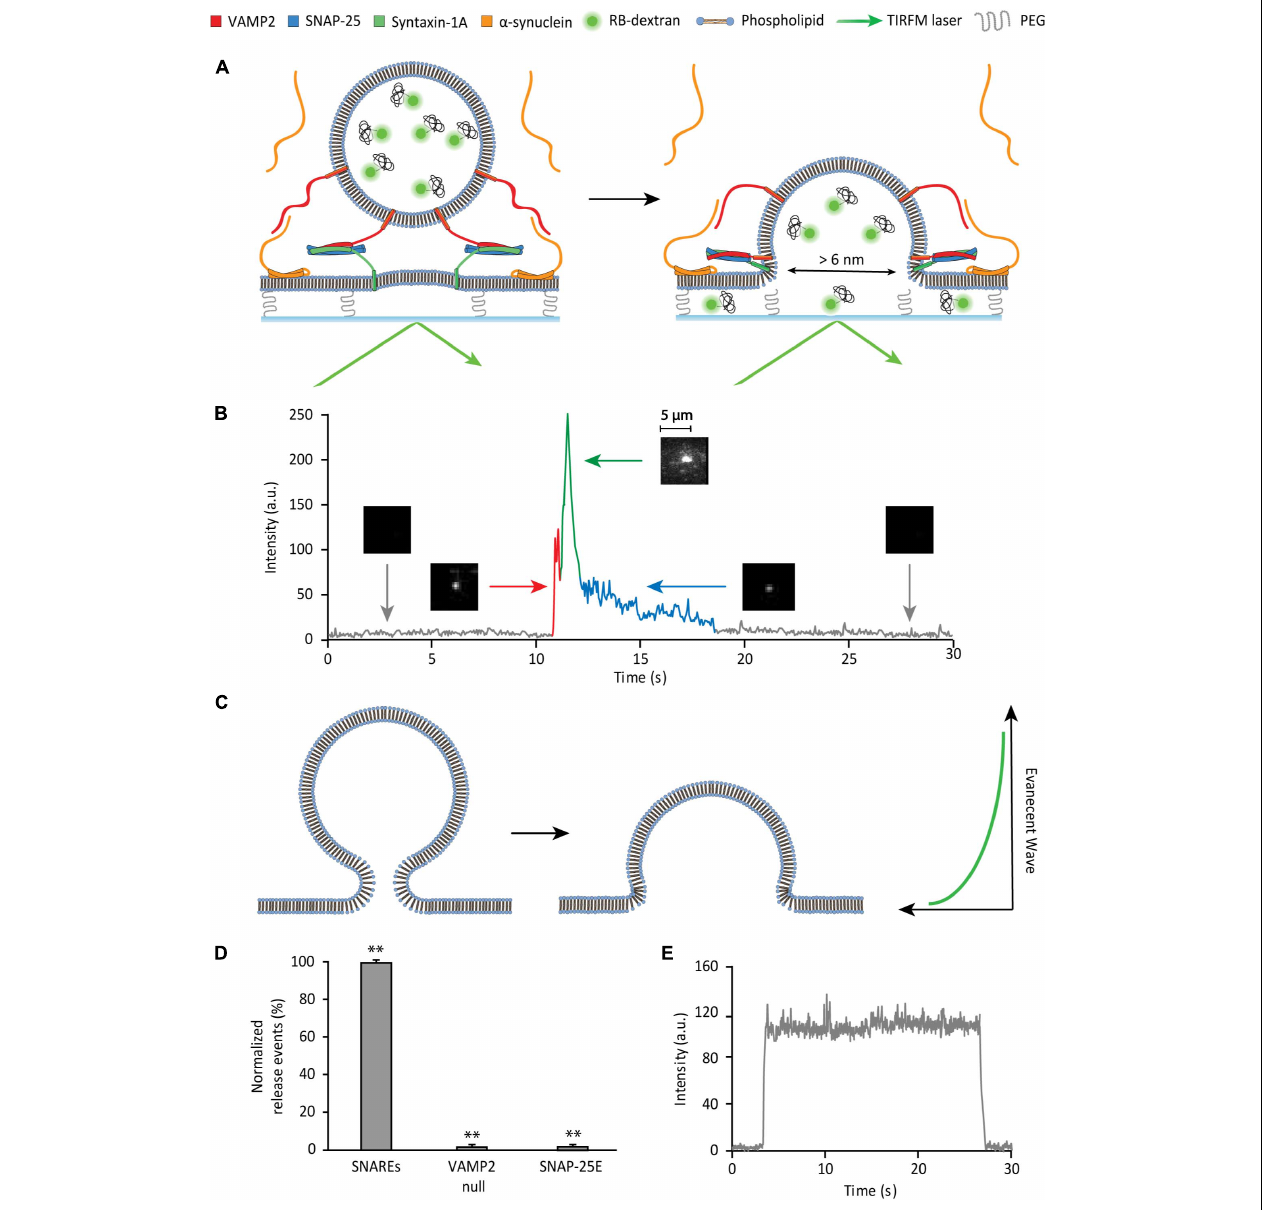
FIGURE 2 | Single vesicle-to-supported bilayer fusion assay to monitor a large fusion pore. (A) Schematic of the content release assay. (B) Detection of large pore fusion event. Before the injection of vesicles, there is a black background (gray trace). As vesicles are injected and dock to the surface, there is a spike in the fluorescence intensity (red trace) visualized by a fluorescent spot. After a short plateau (red trace), the vesicle develops a large fusion pore, where the fluorescence intensity increases sharply and declines sharply thereafter (green trace). During this period of increase and decline, the vesicle discharges content, which can be visualized by 2D diffusion of fluorophores. As the large pore contracts in size, the internal content escapes slowly, producing a slow decay (blue trace). The 2D diffusion of fluorophores is the criterion that divides the green trace and the blue trace. During the blue trace, 2D diffusion of fluorophores is not observed. This is visualized by a gradual dimming of the fluorescent spot to the black background. (C) Hypothetical model of membrane deformation in vesicle fusion. Here, SNARE complexes are not shown for clarity. (D) Controls for the SNARE dependence of the large fusion pore. The data are shown as means ± SD. ∗∗ p < 0.01 by Student’s t -test; n = 3 independent experiments. (E) Fluorescence trace of a non-release event. There is no decay in fluorescence over the span of over 20 s, indicating photobleaching is negligible.